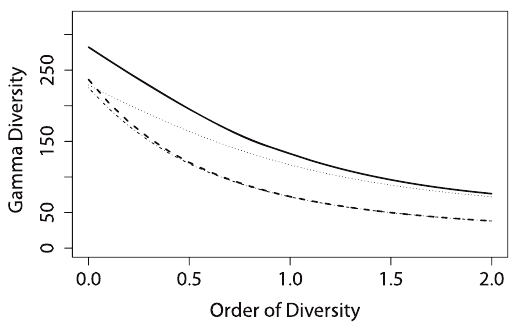
Figure 4. Paracou and BCI c diversity. Diversity of the forest stations is compared. Solid line: Paracou with bias correction; dotted line: Paracou without bias correction; dashed line: BCI with bias correction; dotted dashed line: BCI without bias correction. Without bias correction, Paracou and BCI diversities appear to be similar for low values of q . Bias correction shows that Paracou is undersampled compared to BCI (actually around 1000 trees versus 25000). Paracou is much more diverse than BCI.